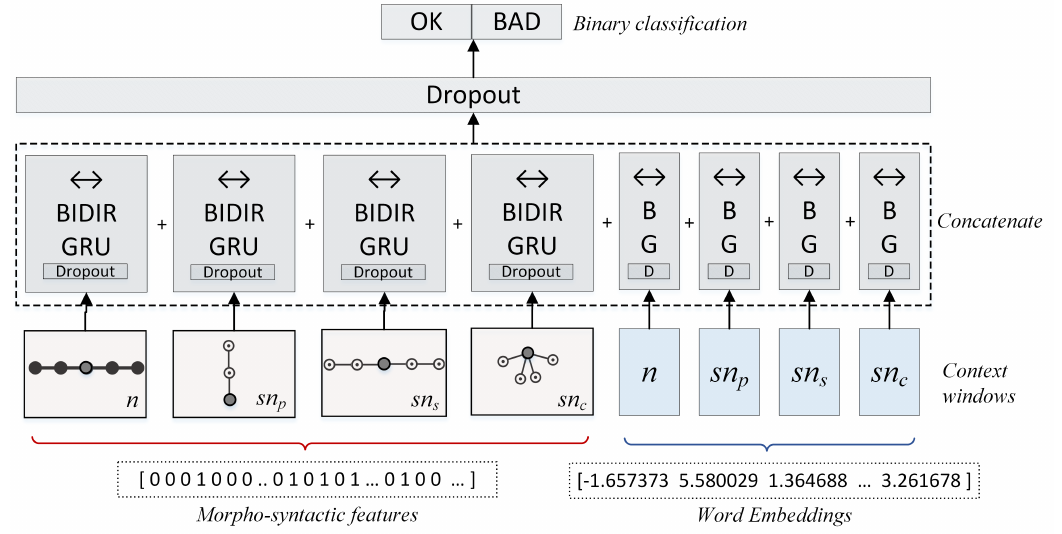
Figure 7. The proposed neural network architecture for detecting fluency errors. While n represents a surface n -gram, sn p , sn s and sn c represent syntactic n -grams obtained around the target word by considering its parents, siblings and children as context in a given dependency